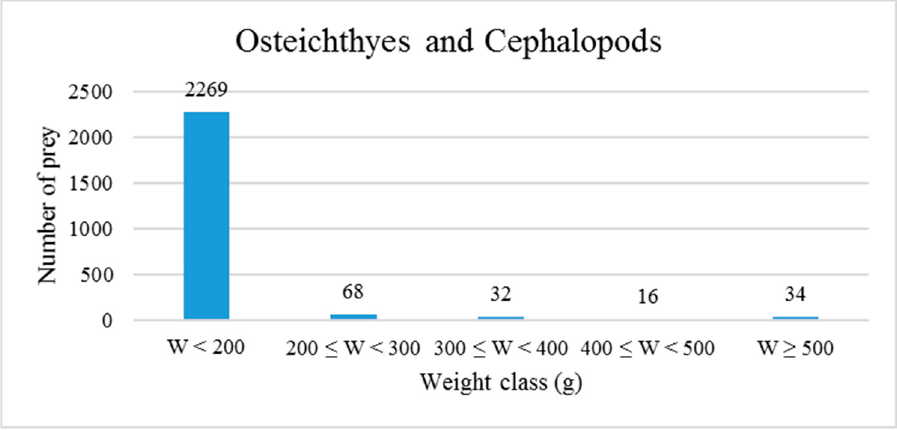
Figure 6. Frequency distribution of prey (fishes and cephalopods) according to weight classes. W: weight.